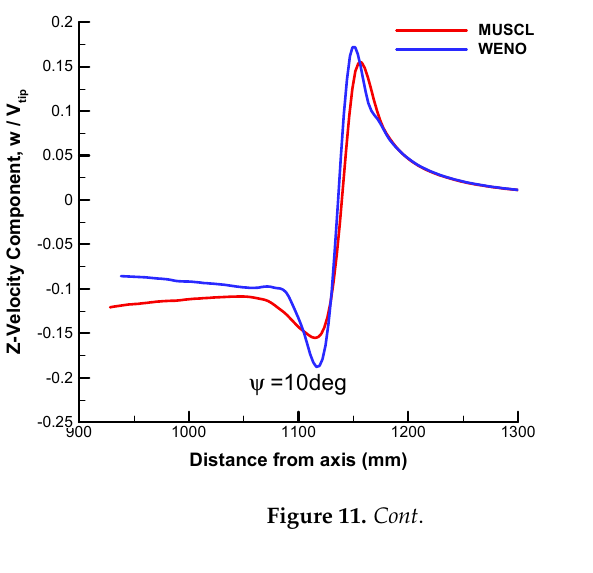
Distance from axis (mm) Figure 10. Probe line of blade tip vortex core and the definition of vortex core diameter.